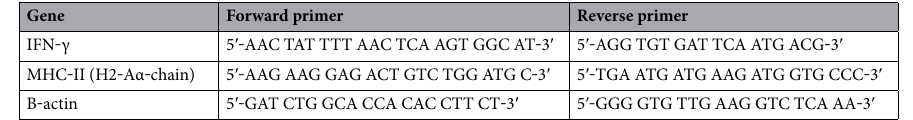
Table 1. List of primers used in the